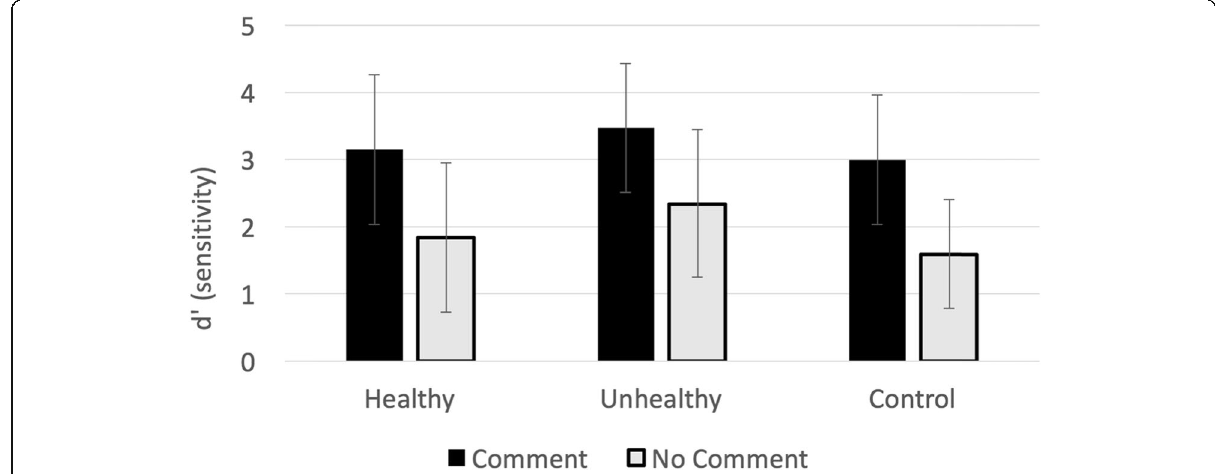
Fig. 2 Experiment 2: Illustration of memory sensitivity ( d ′ ) by condition. Error bars indicate by-participant standard